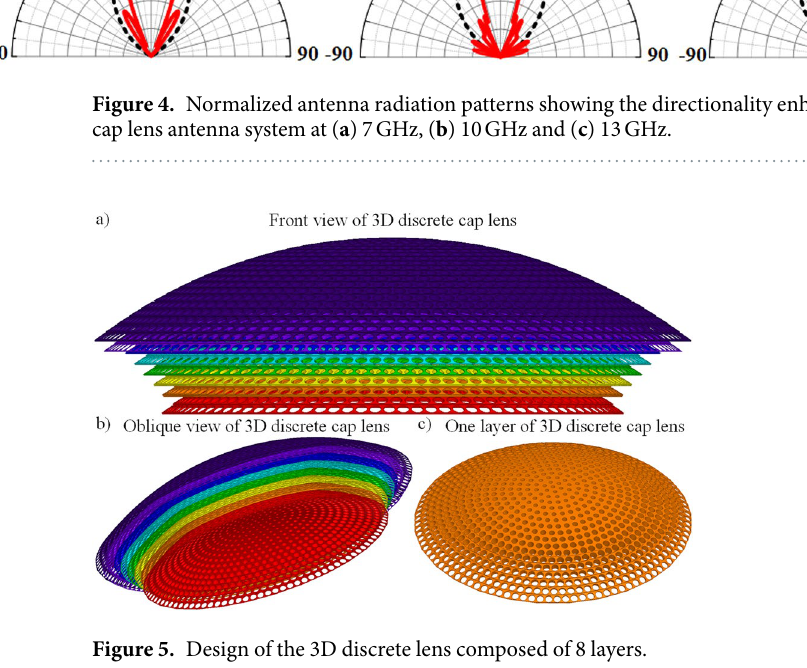
Figure 5. Design of the 3D discrete lens composed of 8 layers.